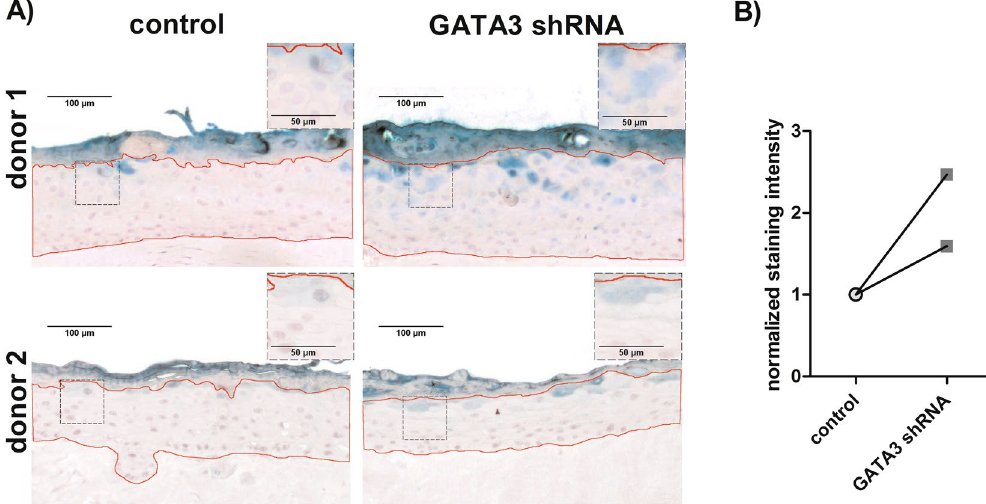
Figure 3. Penetration assay of GATA3 silenced and control cells. ( A ) 3D skin models were constructed from GATA3 silenced and control keratinocytes and a penetration assay was performed. The red-framed areas indicate the fields which were measured for the quantification depicted in 3B. The respective isotypes controls are depicted in Supplementary Fig. S1. ( B ) Immunohistochemical staining of the Lucifer Yellow treated 3D skin models was quantified; the normalized staining intensity of the Green solution is depicted. For quantification, the staining intensity of the epidermis with the exception of the stratum corneum (red-framed area delineated in 3 A) was measured and normalized to the area, n = 2.